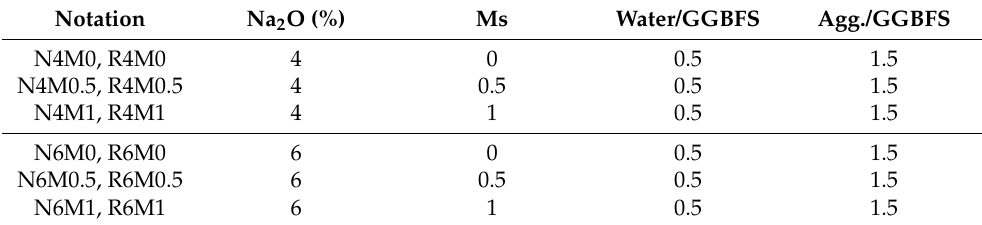
Table 3. Formulations